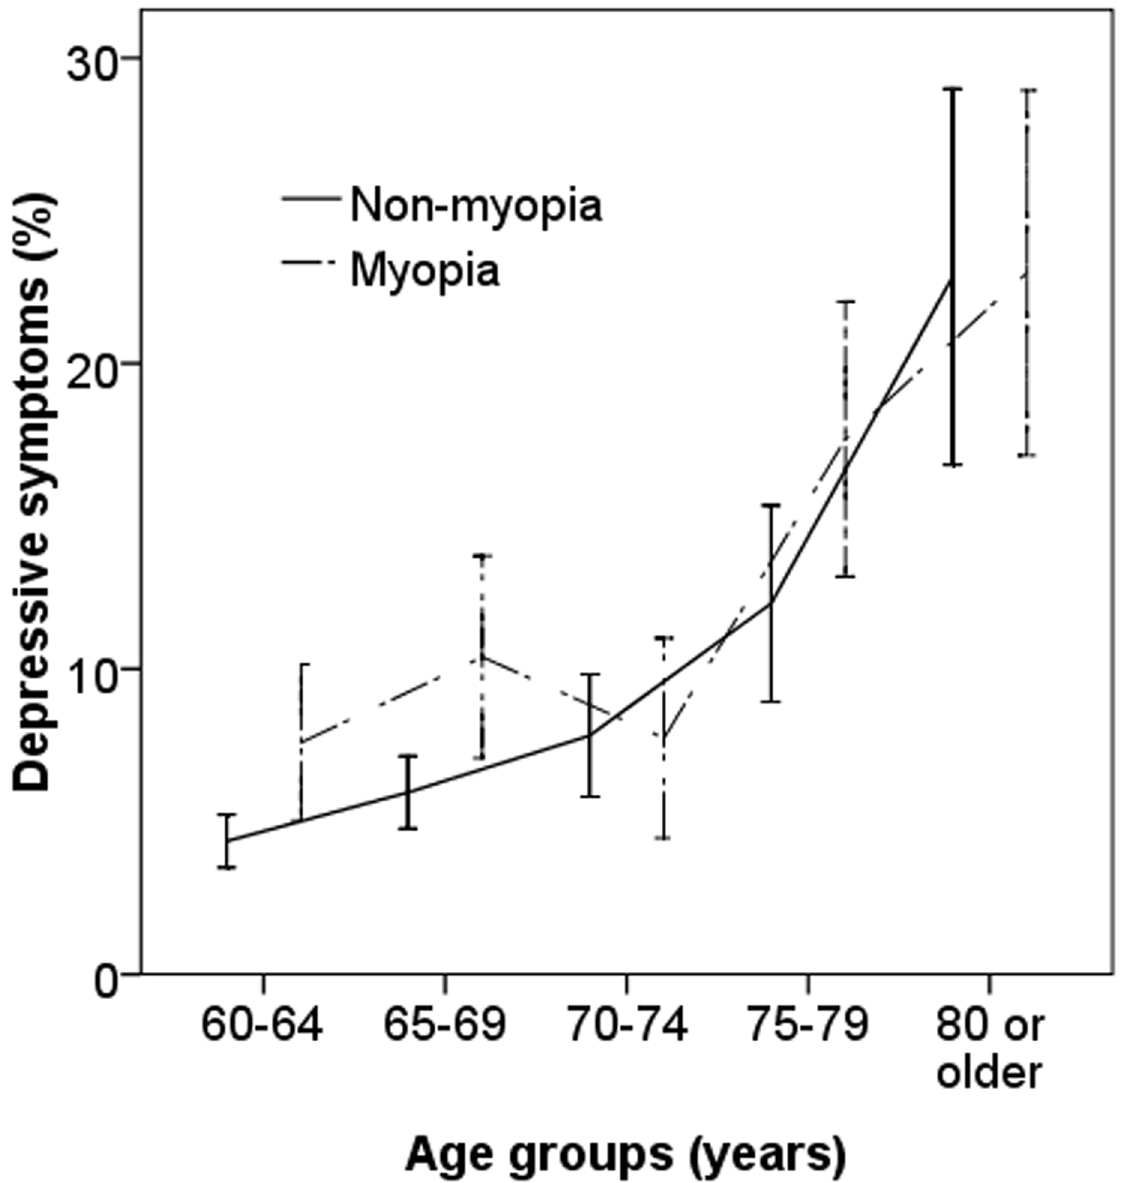
Fig 4. Age-specific prevalenceof depression by